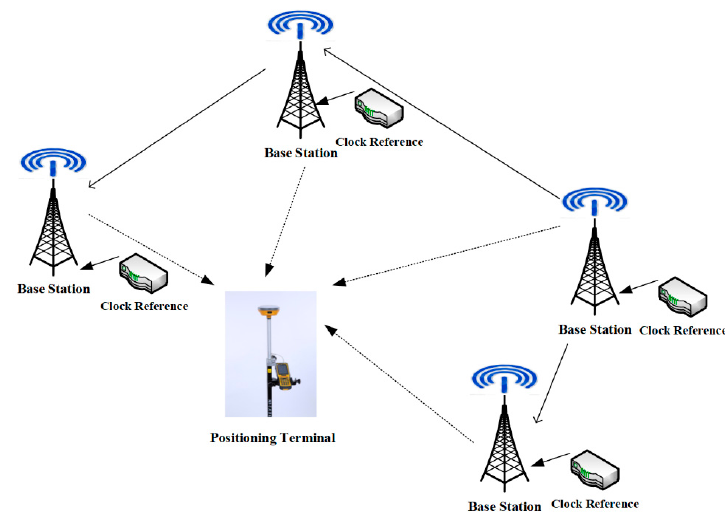
Figure 1. Schematic diagram of pseudolite